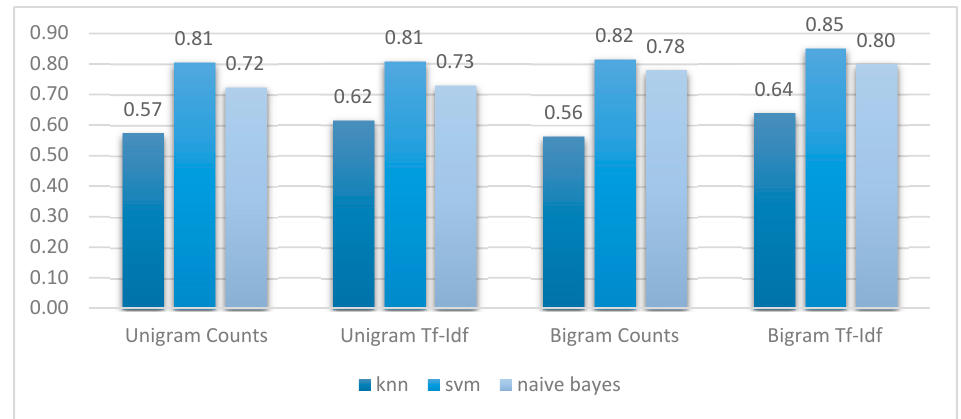
Figure 2. The accuracy using N-gram methods (unigram, unigram TF-IDF, bigram, bigram TF-IDF) with the classifiers (SVM, NB, KNN).